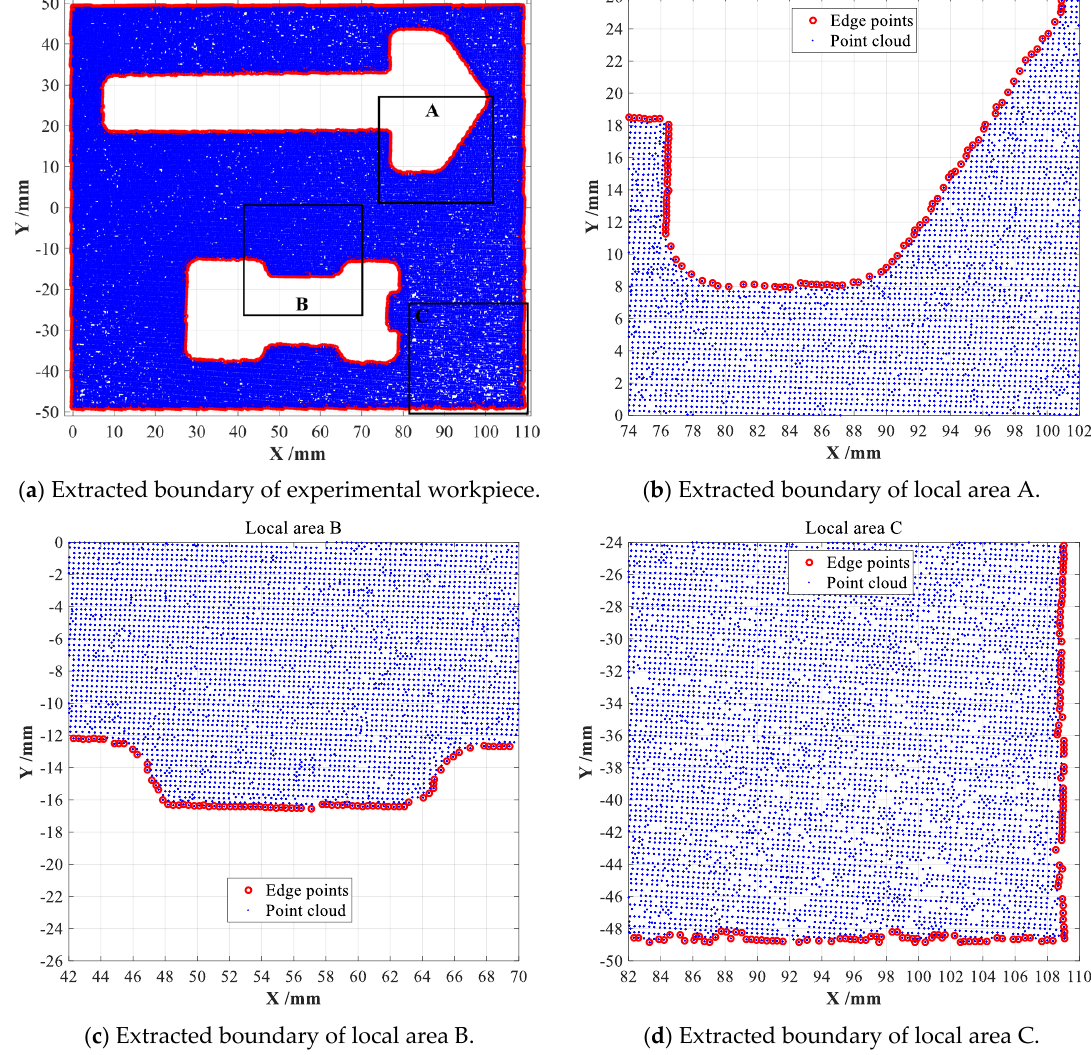
Figure 14. The CDTM-based boundary extraction experiments on complex-shaped point clouds.